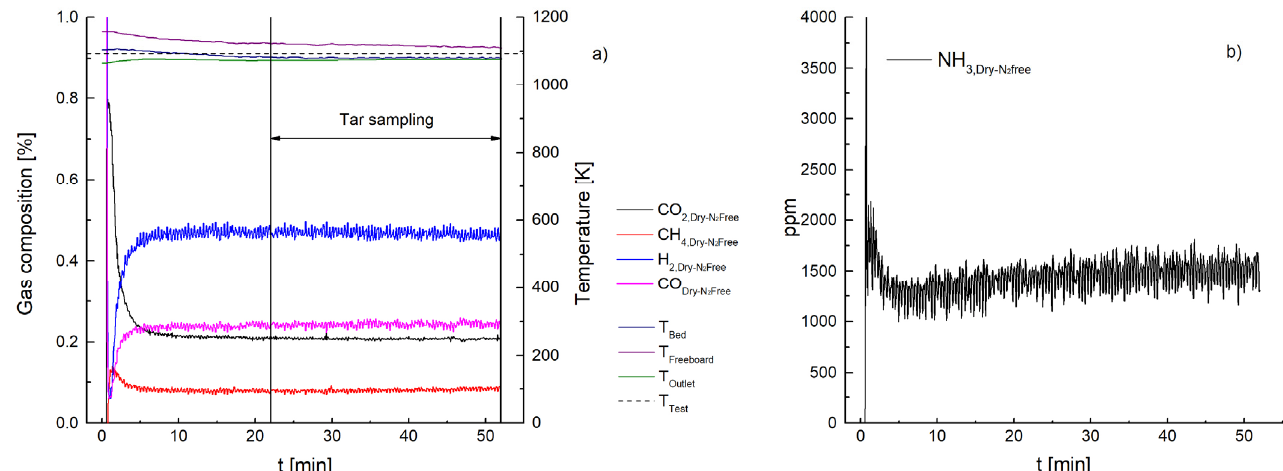
Figure A3. Temperature and gas composition ( a ) and ammonia content ( b ) during test 3.